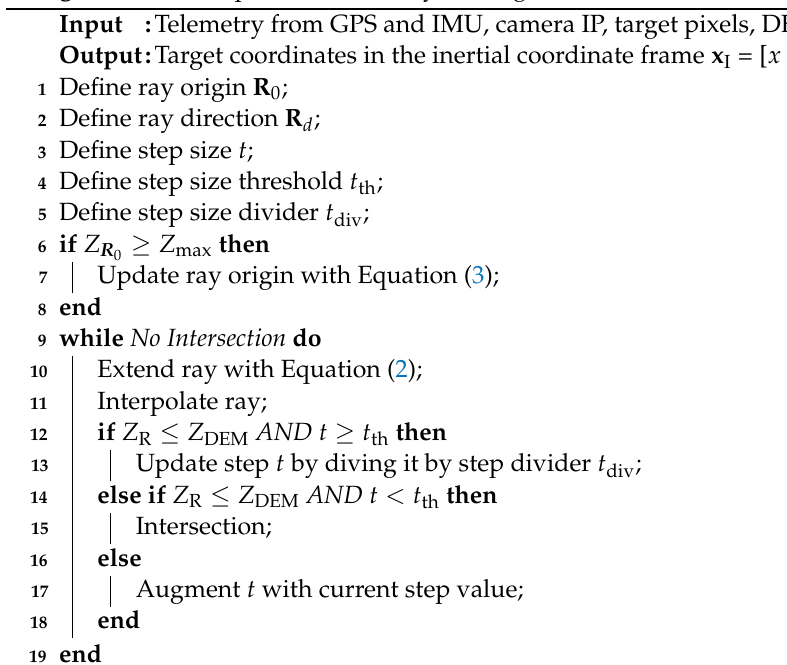
Algorithm 1: Complete Iterative Ray-Tracing.